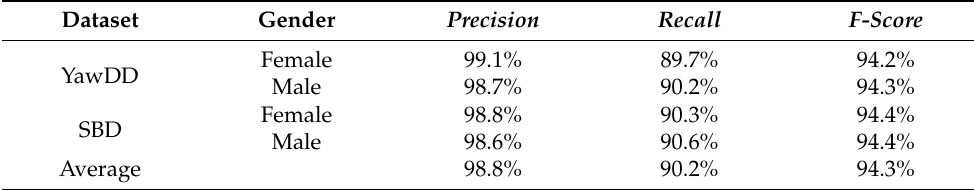
Figure 13. The effect of the actual scene MAX-MIN detection method. ( a ) Female normal driving; ( b ) Female driver yawning; ( c ) Female drivers close their eyes; ( d ) Male normal driving; ( e ) Male driver yawning; ( f ) Male drivers close their eyes. Table 3. Performance metrics of the MAX-MIN algorithm for detection in YawDD and SBD datasets.